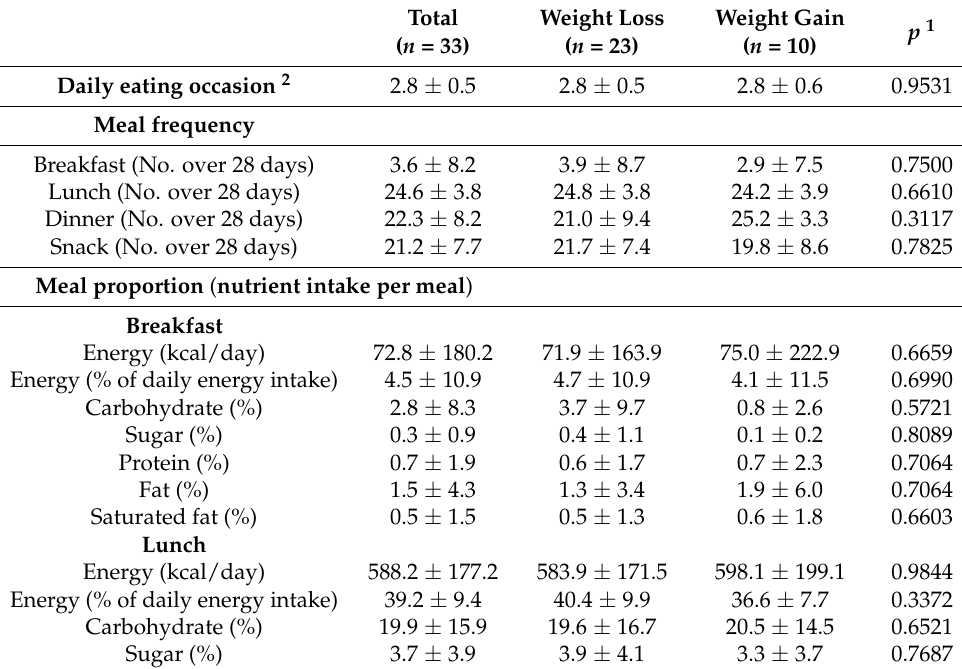
Table 5. Meal frequency and meal proportions in 4 weeks of time-restricted